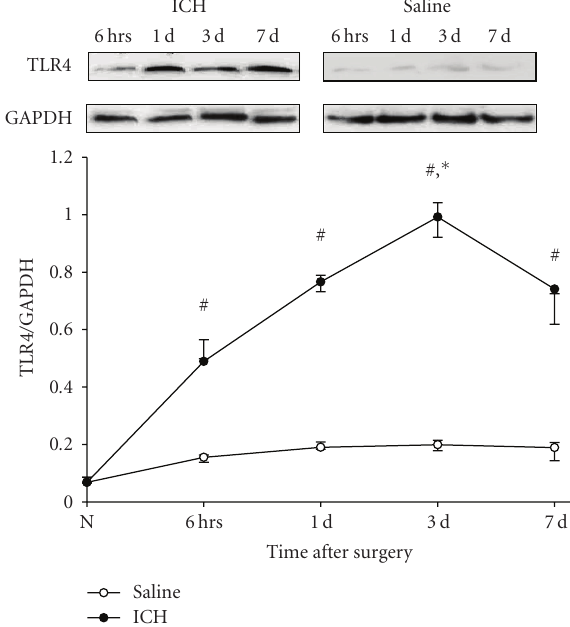
Figure 2: The temporal changes of TLR4 protein in brain tissue after ICH . The expression of TLR4 protein was measured in brain tissue by the method of Western Blots using specific antibody for TLR4. The signals were quantified by scanning densitometry and computer-assisted image analysis and expressed as the ratio of TLR4 protein to GAPDH. The results showed that low level of TLR4 protein was detectable in the saline control group. The expression of TLR4 significantly increased starting from 6 hours after ICH ( P < . 05), peaked on 3 days after ICH, and then decreased but still maintained at a high level on 7 days after ICH ( P < . 05). #: compared with saline control, P < . 05; ∗ : compared with 6 hours after ICH, P < .